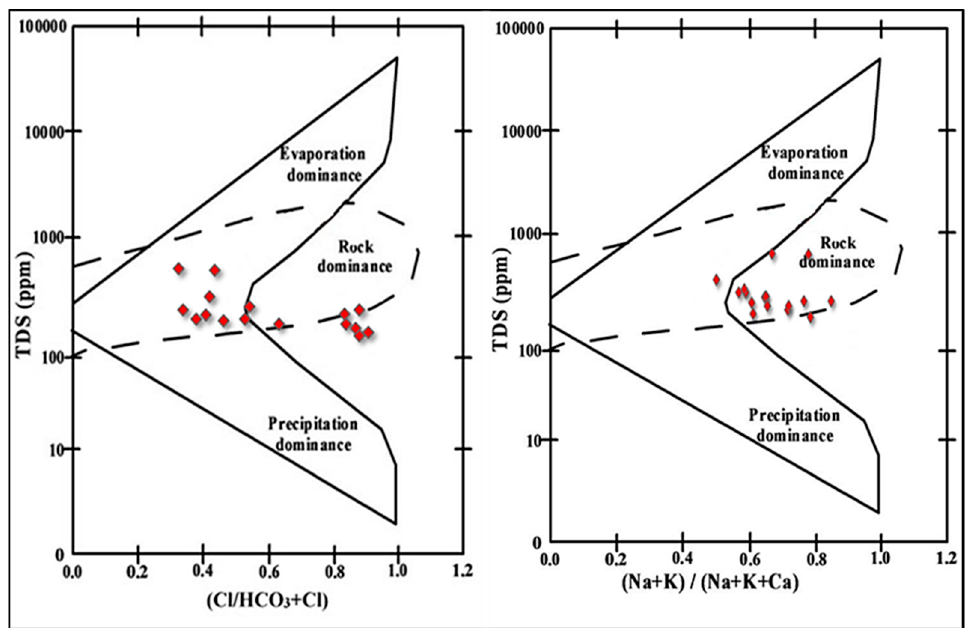
Figure 7. Gibbs diagram showing the ratio of (Cl − /HCO 3 − + Cl − ) and (Na + + K + )/(Na + + K + + Ca 2+ ) vs. TDS.